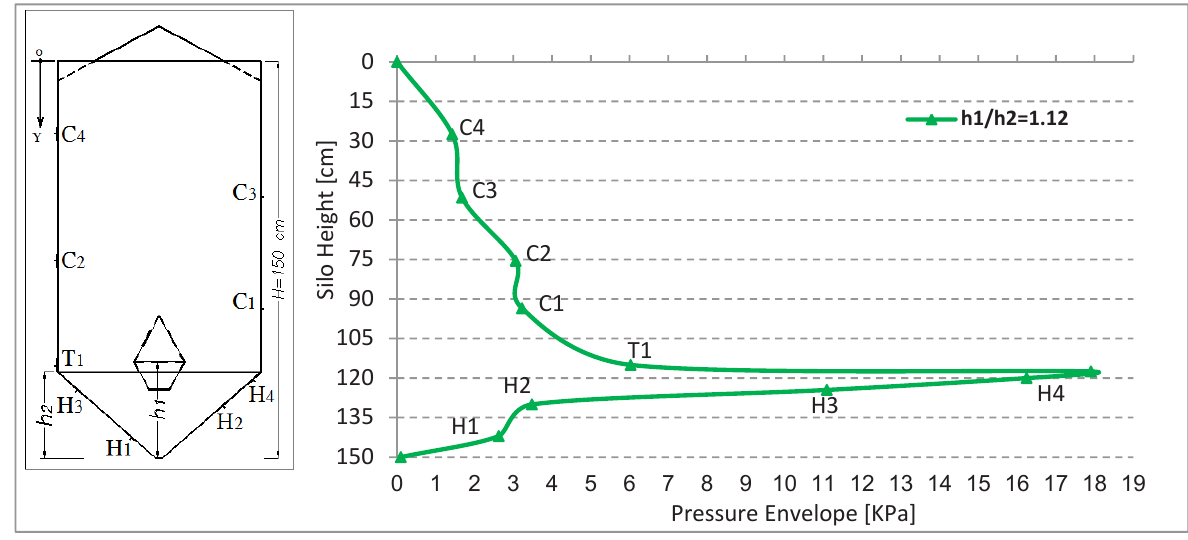
Fig. 10 The pressure distribution on the silo wall and hopper with Insert at position h